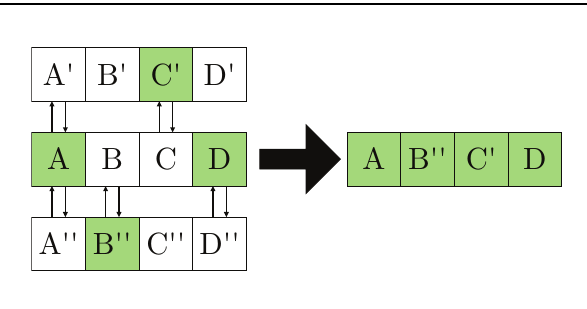
Figure 4. The crossover of different genes.